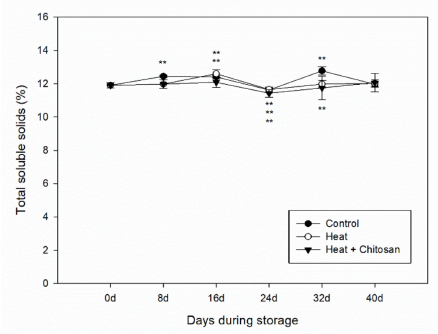
Figure 2. Total soluble solids of ‘Sanhua’ plum fruit during storage. Error bars represent for standard errors. Control: fruits without treatment; Heat: fruits with hot air treatment at 37 ◦ C for 6 h; Heat and Chitosan: fruits treatment with hot air (37 ◦ C, 6 h) and 1% chitosan. ** mean significant di ff erences at p < 0.01 level,